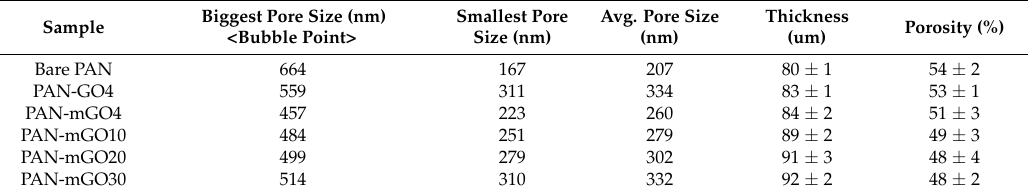
Table 1. Integrity of bare Bare polyacrylonitrile (PAN) and PAN-GO composite membranes as a function of graphene oxide (GO)